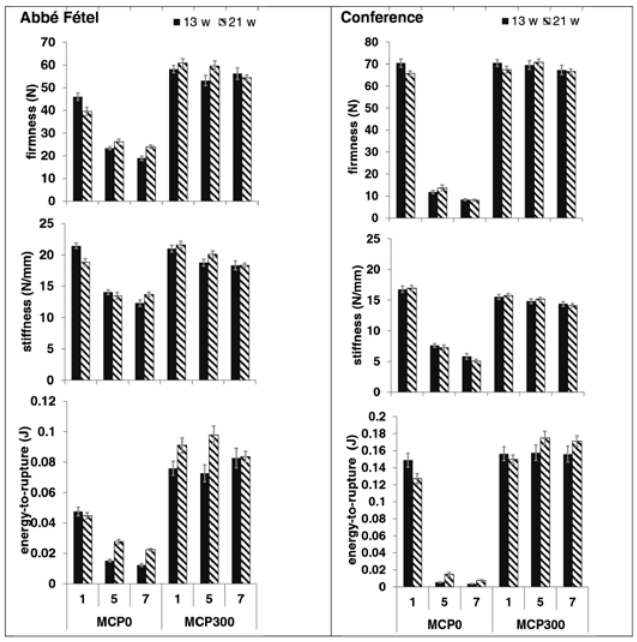
Fig. 4 - Firmness, stiffness and energy-to-rupture of control (MCP0) and 1-MCP treated (MCP300) ‘Abbé Fétel’ and ‘Conference’ pears after 1, 5 and 7 days of shelf life at 20°C after 13 and 21 weeks of storage. Bars refer to standard error of the mean. Re- sults of ANOVA analysis are reported in Table 3.